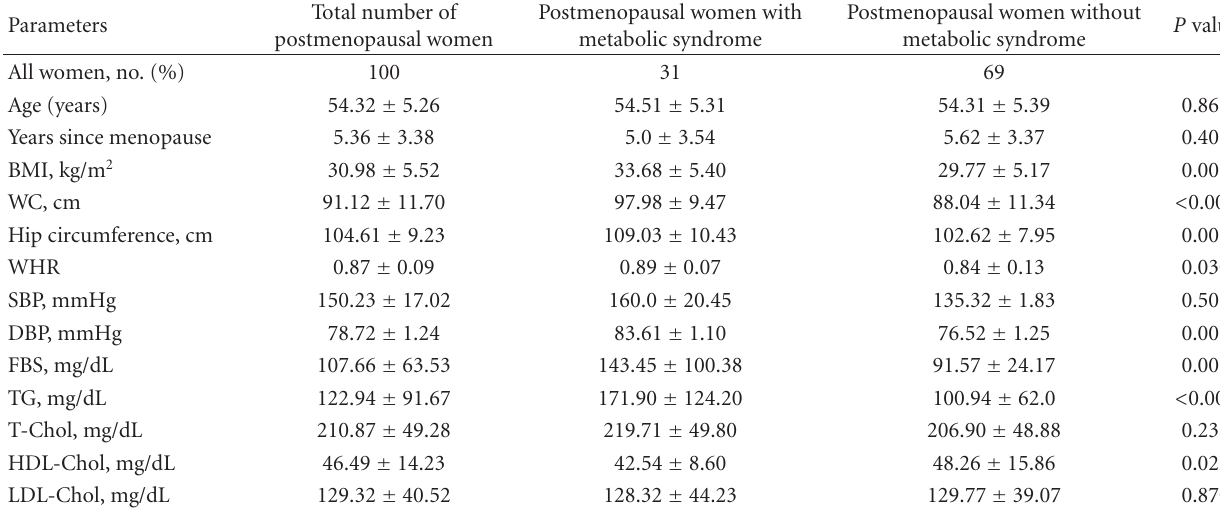
Table 1: Baseline data of postmenopausal women (total subjects and subjects with and without metabolic syndrome). Parameters